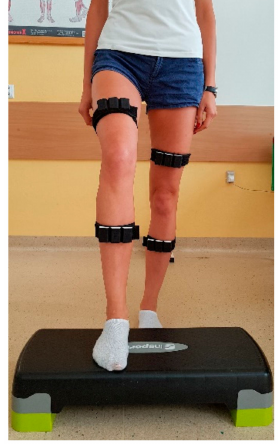
Figure 3. Recording in step up